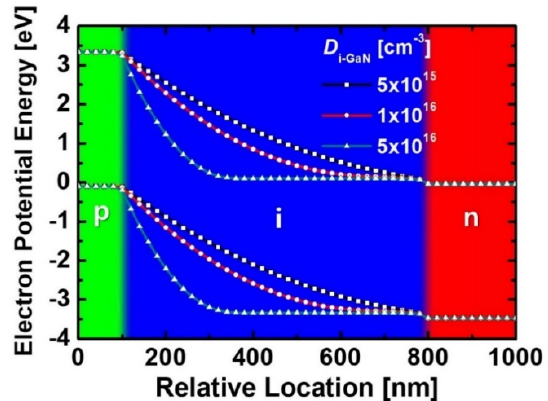
Figure 5. Energy band diagrams of the diodes with different values of D i-GaN . All the devices were designed with a H p-GaN of 100 nm and a H i-GaN of 700 nm. The D p-GaN and D n-GaN of the devices were 5 × 10 17 cm − 3 and 5 × 10 18 cm − 3 , respectively.